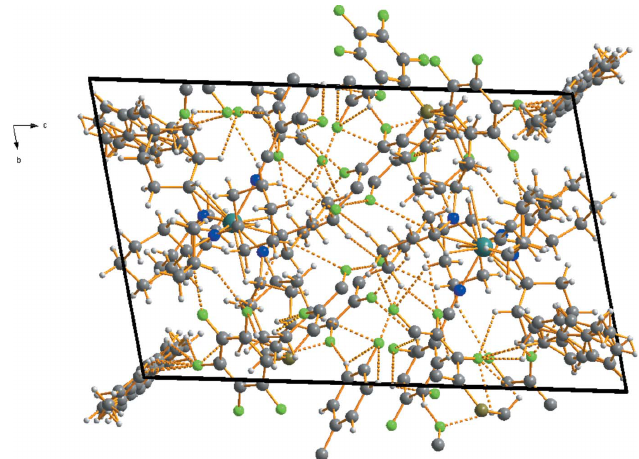
Figure 4 Aview along the a axis showing the packing of individual molecules in the crystal of ( 2 ), with C—H (cid:2)(cid:2)(cid:2)(cid:2) F bonds shown as dashed lines. Both components of the disorder are shown. Colour code: C dark grey, H light grey, N blue, Ti teal, B dark yellow, F bright